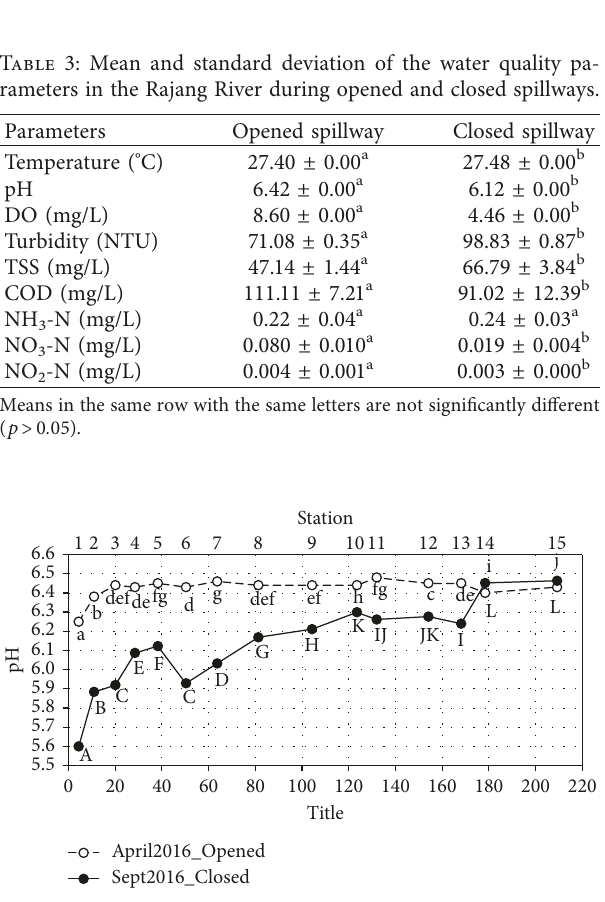
Figure 3: pH at the 15 stations downstream of Bakun Hydro- electric Dam during opened spillway ( o ) and closed spillway ( • ). The same letter indicates no significant difference ( p > 0 .